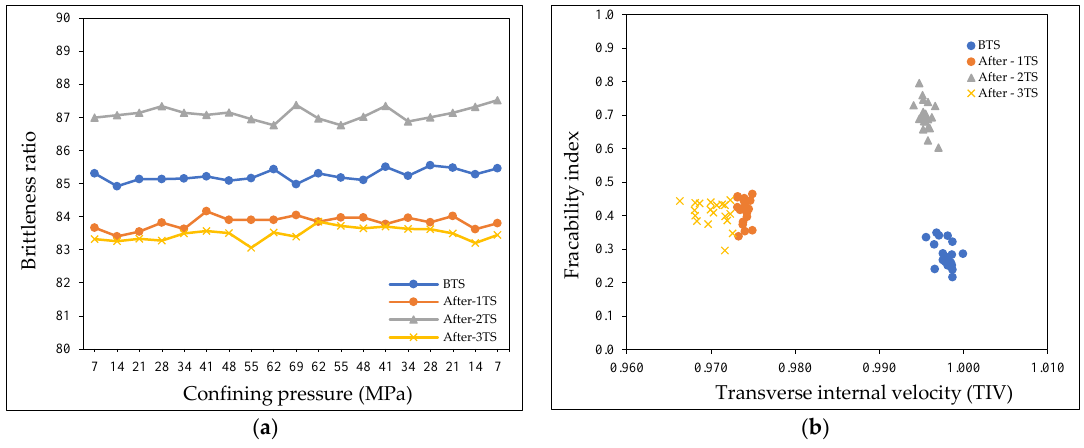
Figure 13. ( a ) Brittleness ratio results of SH#5 at different confining pressures before and after thermal shock; and ( b ) fracability Index of SH#5 vs. transverse internal velocity (TIV) before and after thermal shock.